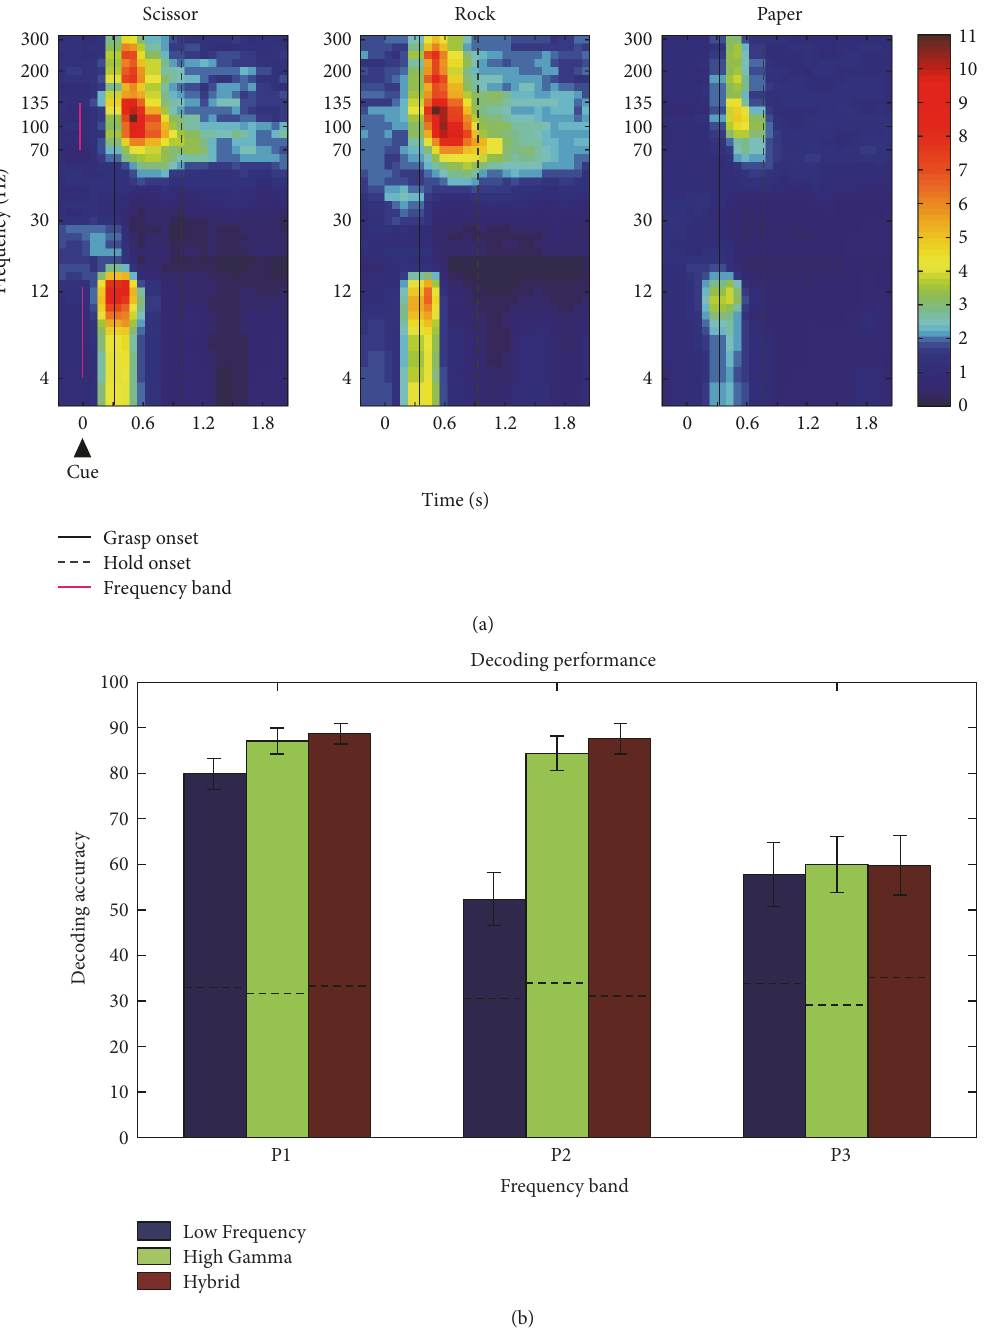
Figure 2: Time frequency plots of the ECoG signals and decoding performance obtained from all channels and selected channels. (a) Normalized power spectrum of ECoG signal from a representative channel 35 over sensorimotor cortex of P1 which was averaged and aligned with visual cue (time=0). The frequency increases in log scale, and the color bar gives the scale of the spectrum amplitude values. The gestures from left to right are scissor, rock, and paper, respectively. Vertical magenta bars in the subplot indicate the frequency bands used in decoding (high gamma frequency band (70 – 135 Hz) and low-frequency band (4 – 12 Hz)). Black solid lines represent the averaged grasping onset across trials, and the grey dash lines represent the averaged end timing of grasping. (b) The decoding performance of di ff erent frequency bands (low-, high-, and hybrid frequency band, from left to right) using all channels (left column). The performances of hybrid frequency band are signi fi cantly higher than that of high frequency band in P1 and P2 ( p value < 0.01), and both the hybrid and high frequency decoding results are higher than low frequency in all participants. The black dash line represent the chance